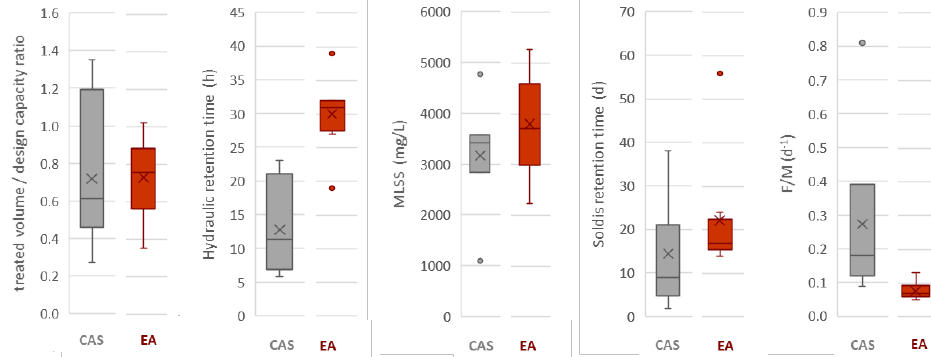
Figure 1. Boxplots of the operating conditions for the two clusters of AS-WWTPs (5-year data, 9 CAS-WWTPs and 7 EA-WWTPs).